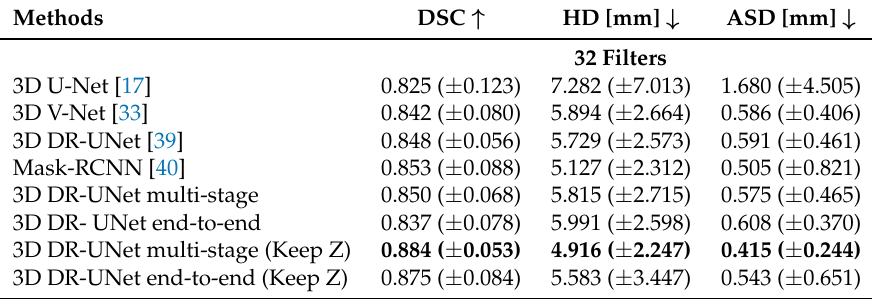
Table 3. Segmentation performance of different network architectures on the ACDC STACOM 2017, evaluated using the DSC, HD and ASD metrics (mean ± (std)). Filters denote the initial number of convolution kernels used by each network.